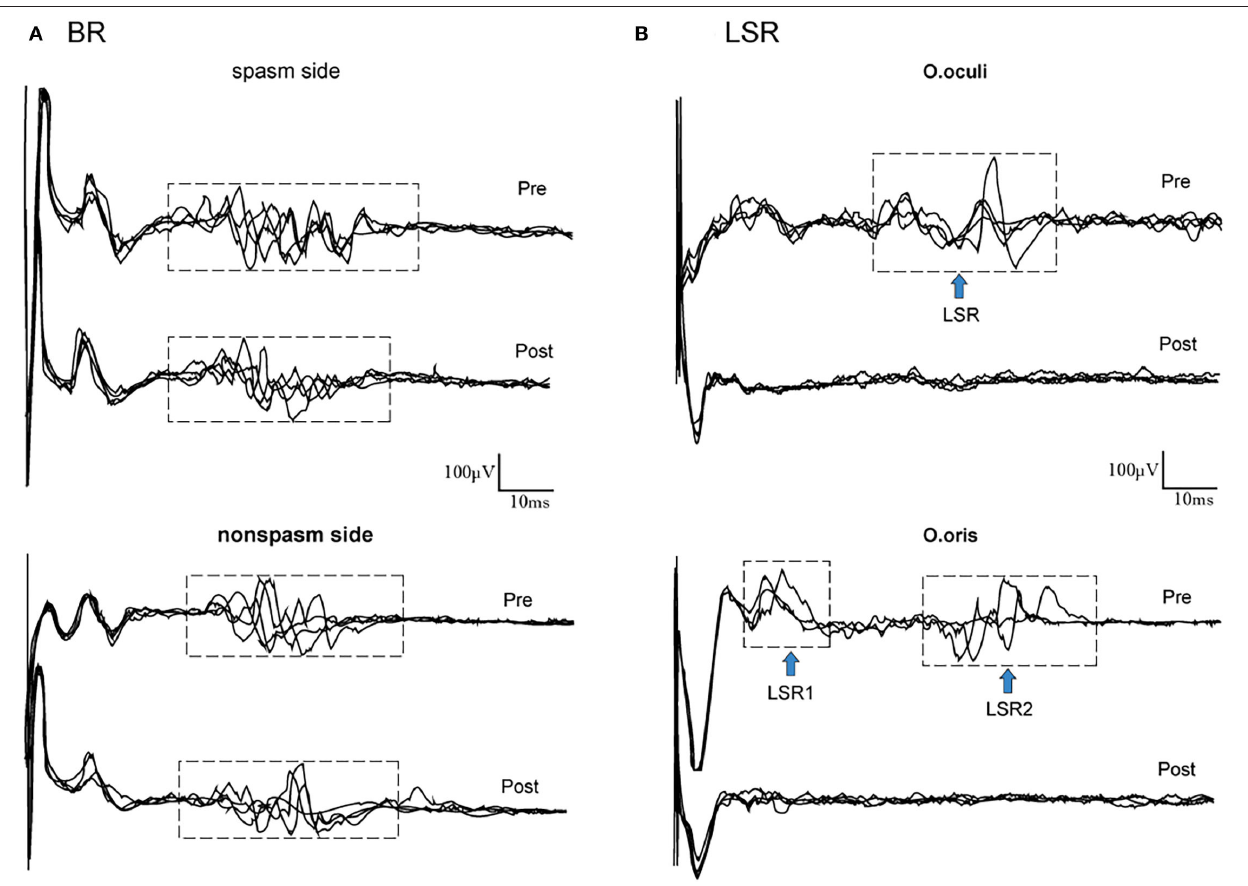
FIGURE 1 | Raw data of BR and LSR. (A) Changes in BR. Compared to nonspasm side at baseline, the amplitude of R1 was higher, the duration of R2 was longer, and the area of R2 was larger in the spasm side. After 30 weeks of EA treatment, the duration of R2 was shortened and the area of R2 was reduced in the spasm side, and there were no changes in the nonspasm side. (B) Occurrence of LSR in O.oc and O.or (the blue arrow). After EA, no LSR was found in the facial muscles. BR, blink reflex; LSR, lateral spread responses; O.oc, Orbicularis oculi muscle; O.or, Orbicularis oris